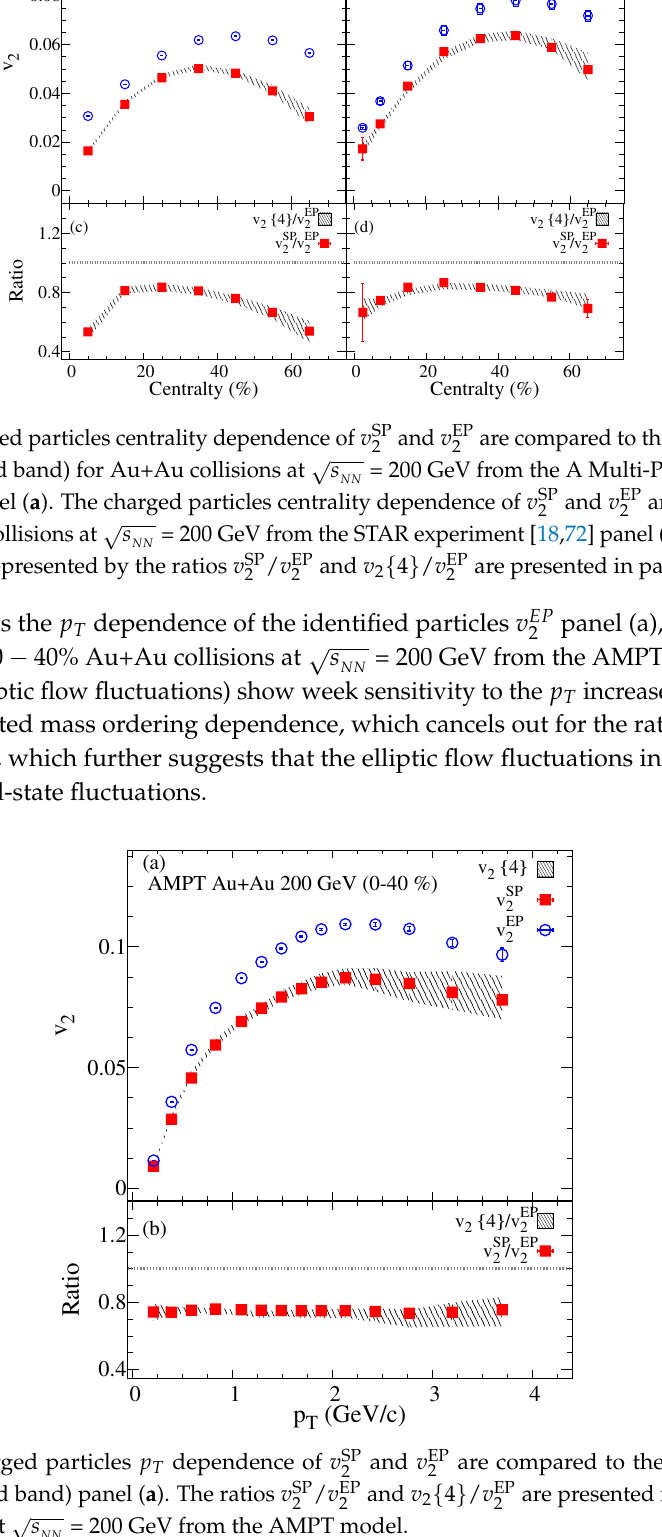
√ s = 200 GeV from the AMPT NN